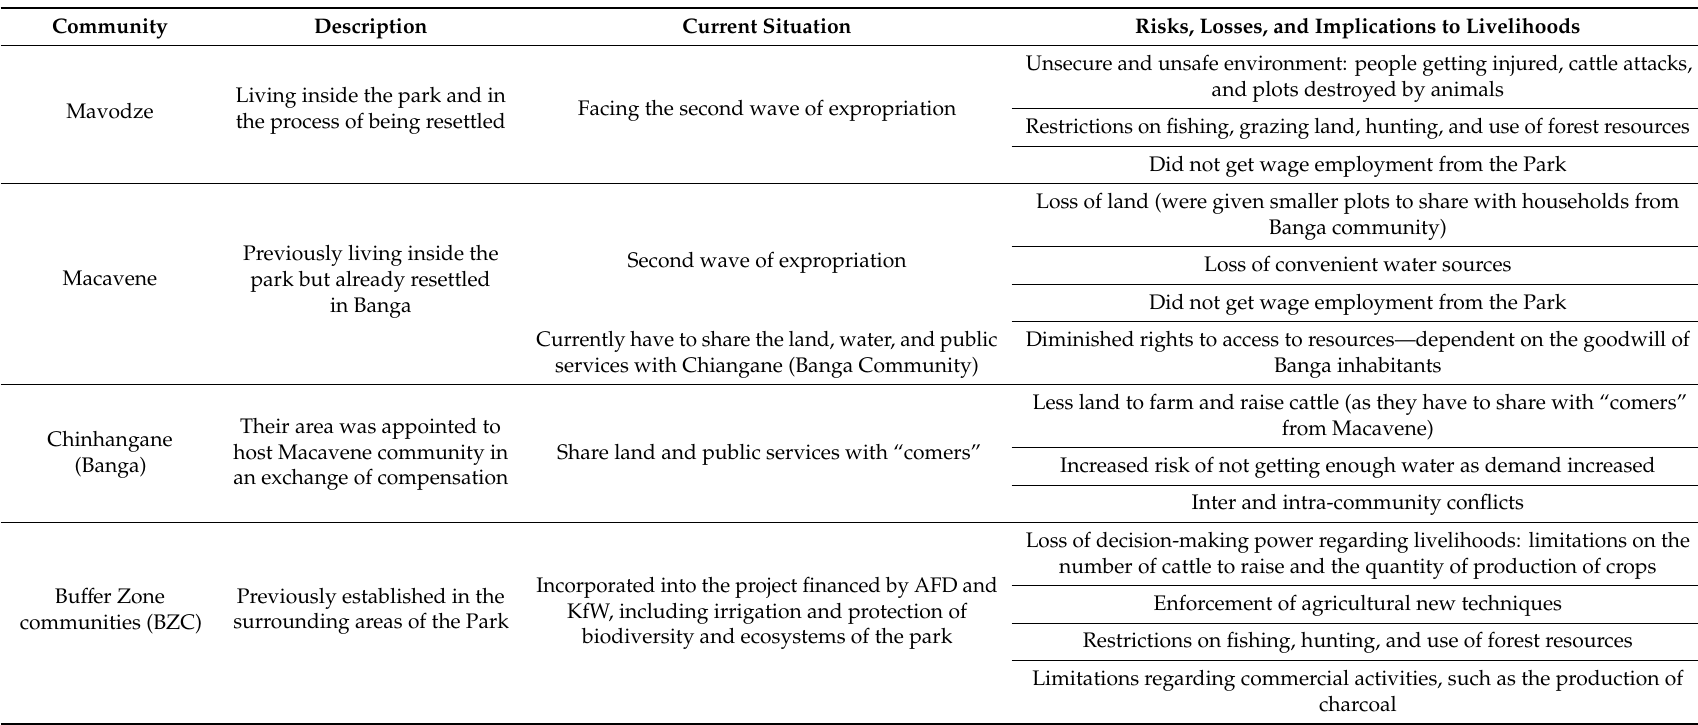
Table 2. Communities a ff ected by the processes of reconcentration of land in Massingir